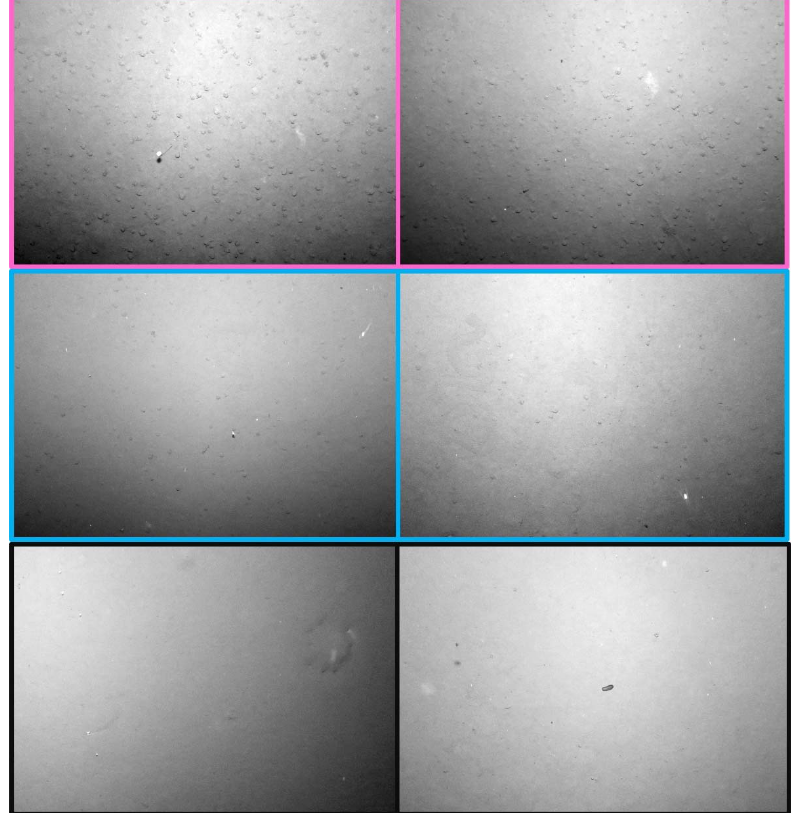
Figure A1. AUV grayscale images from within the DEA area. Top: high number of PMN; middle: lower number of PMN; bottom: no PMN. The colored frames correspond to the spatial clusters (Section 3.1).